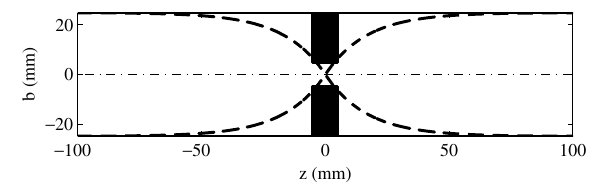
FIG. 13. Smooth approximation of the scraper